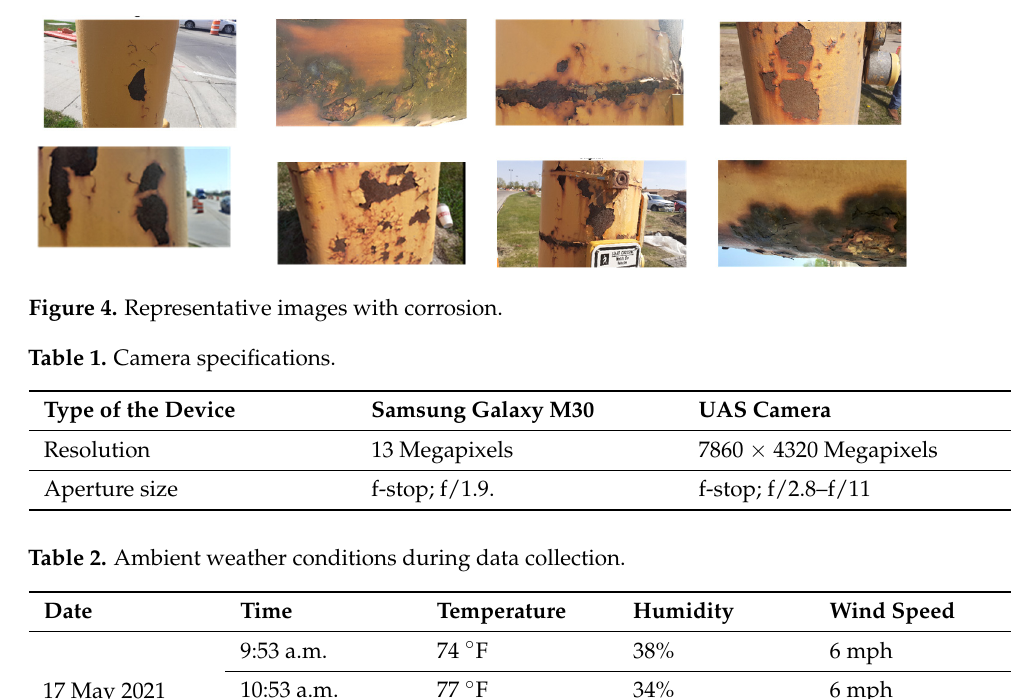
Table 2. Ambient weather conditions during data collection.